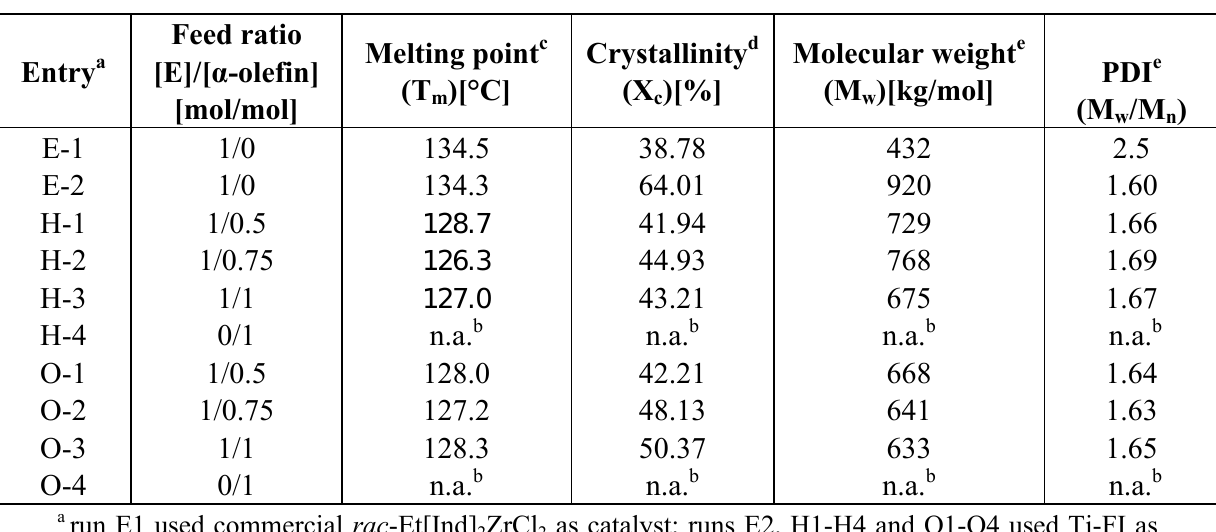
Table 2. Properties of resulting